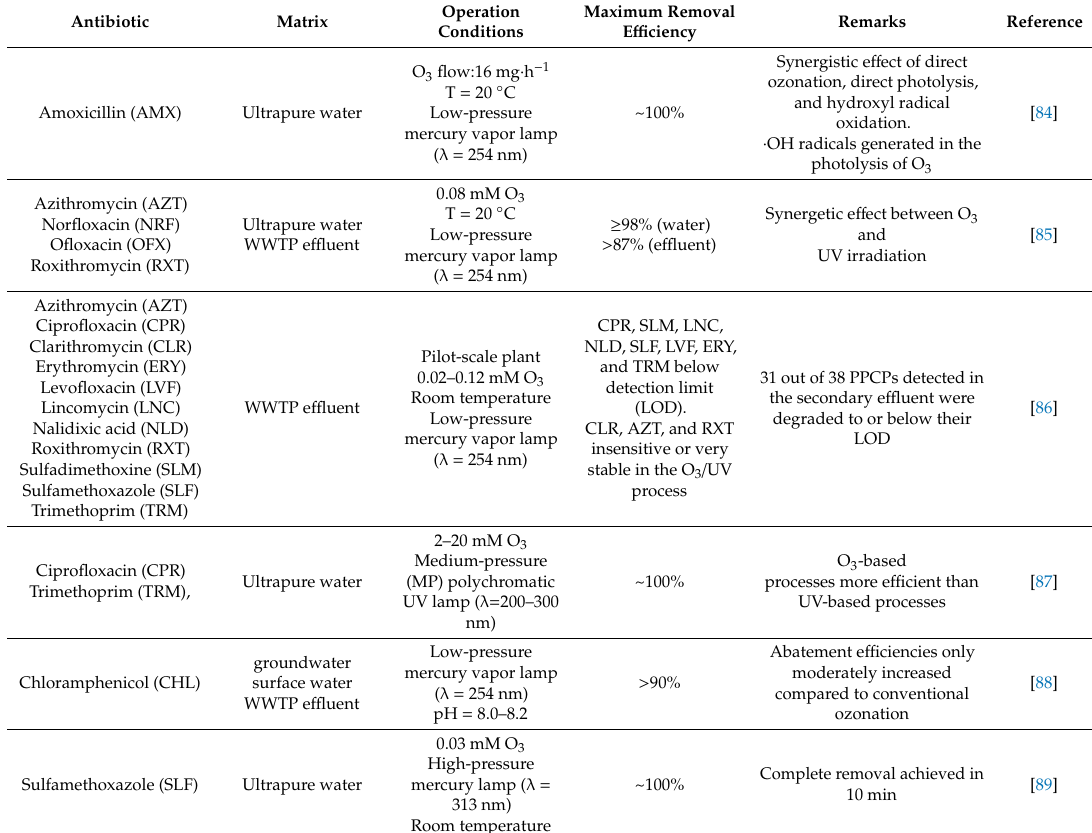
Table 6. Removal e ffi ciency of antibiotics in waters by the O 3 / UV